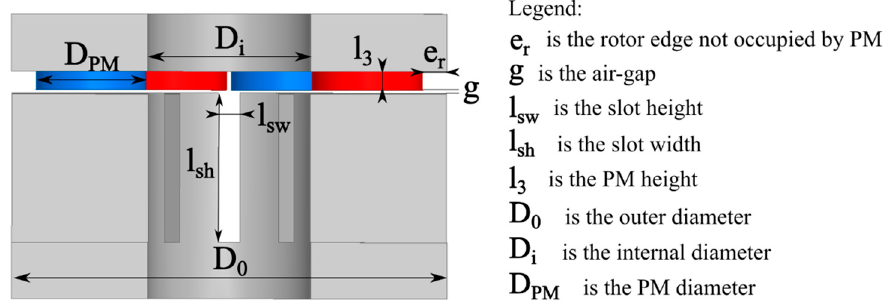
Figure 5. AFPMGS geometry and main parameters. Table 4. AFPMGS configurations.